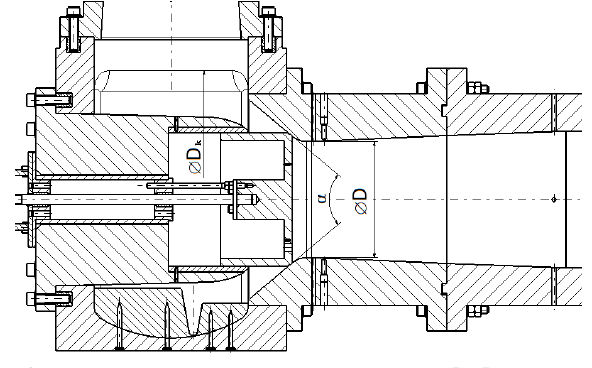
Fig. 2. Cross-section through the compact valve [12]